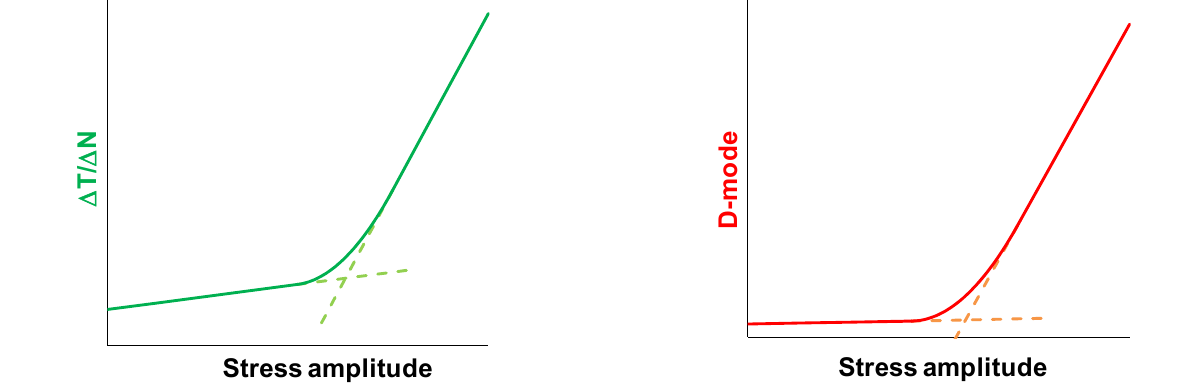
Figure 2: Schematic representation of the classic Δ T/ Δ N trend with respect to the stress amplitude.